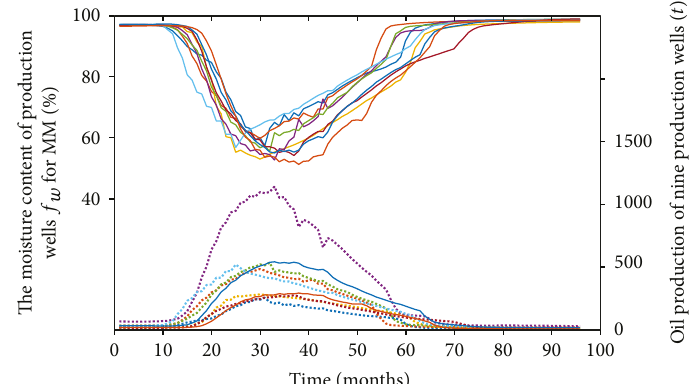
Figure 13: The moisture content and oil production of production wells for